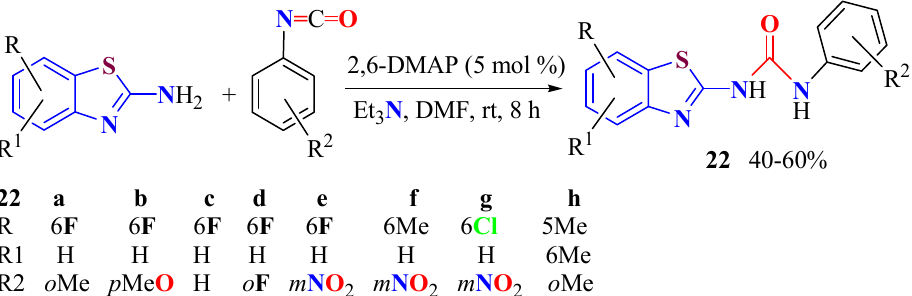
Figure 3. Use of CDI or TCDI to afford substituted-aryl-UBTs 17 , 19 , 20 and -aryl-TBTs 18 . The phenyl-TBT 21 has been isolated from thermal transformation of 3-phenylamino- 5-phenylimino-1,2,4-dithiazole via intramolecular rearrangement through intermediate A , Scheme 8 [126]. Analogous thermal or acidic catalyzed rearrangements have been de- scribed [127]. S H NS N N H A Scheme 8. Phenyl-TBT 21 from rearrangement of 3-phenylamino-5-phenylimino-1,2,4-dithiazole. A series of aryl-UBTs 22 has been synthesized in 40–60% yield from the reaction of the substituted 2ABT with the corresponding aryl-isocyanate in presence of N , N ′ -dimethylformamide (DMF), triethylamine (TEA), and dimethylaminopyridine (DMAP) stirring for 8h at room temperature, Scheme 9 [128]. The resultant compounds were evaluated for their antiproliferative profiles in human SK-Hep-1 (liver), MDA-MB-231 (breast), and NUGC-3 (gastric) cell lines. Compounds 22e , 22g , and 22h had the potential to moderate inhibitory activities. More of these compounds have been investigated for their ability to inhibit Raf-1 activity. However, they exhibited moderate to poor inhibition.